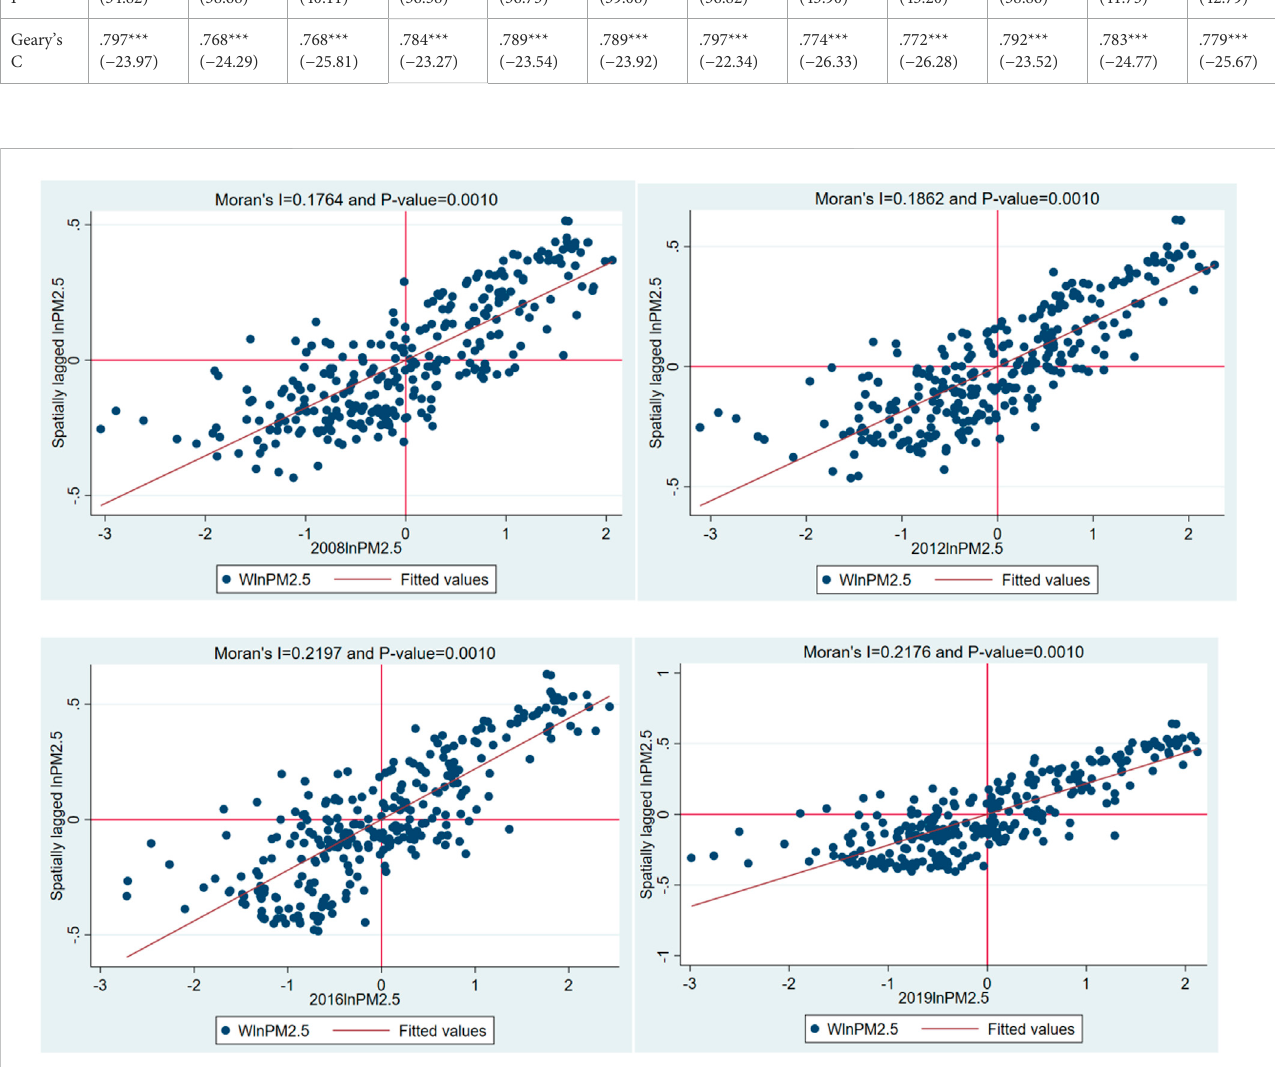
Scatter plots of Moran ’ s I Index of PM2.5 emissions in China ’ s cities with W in chosen years: 2008, 2012, 2016,